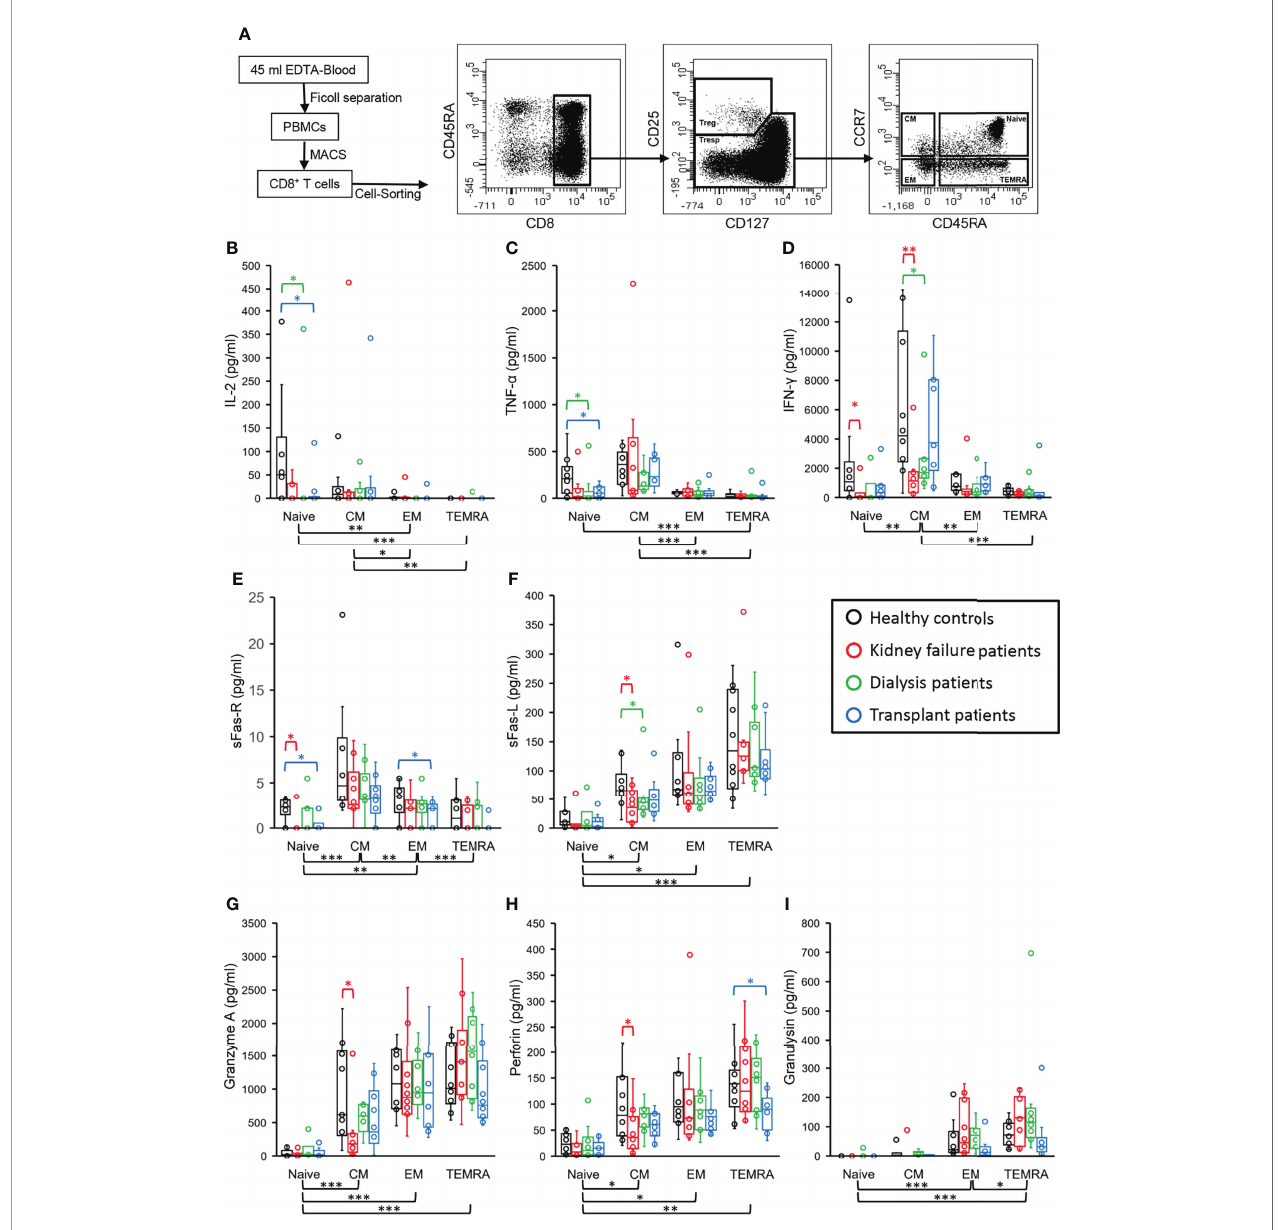
FIGURE 6 | Functionality of naïve, CM, EM, and TEMRA Tresps in age-matched healthy volunteers (n=10), KF patients (n=10), dialysis patients (n=10), and kidney transplant patients (n=10). Total CD8 + T cells were isolated by MACS, stained with anti-CD8, anti-CD25, anti-CD127, anti-CD45RA and anti-CCR7 monoclonal antibodies to identify CD8 + CD25 low+/- CD127 +/- Tresps and sort them into CCR7 + CD45RA + naïve, CCR7 + CD45RA - CM, CCR7 - CD45RA - EM, and CCR7 - CD45RA + TEMRA Tresps (A) . After 72 hours of stimulation with anti-CD3/CD28 speci fi c antibodies, bead-based analysis was performed to detect the concentrations of IL-2 (B) , TNF- a (C) , IFN- g (D) , sFas-R (E) , sFas-L (F) , granzyme A (G) , perforin (H) , and granulysin (I) in the supernatants. Box plots represent the interquartile range with the median as a bar in black for healthy controls, red for KF patients, green for dialysis patients, and blue for kidney transplant patients. *p ≤ 0.05; **p < 0.01; ***p <